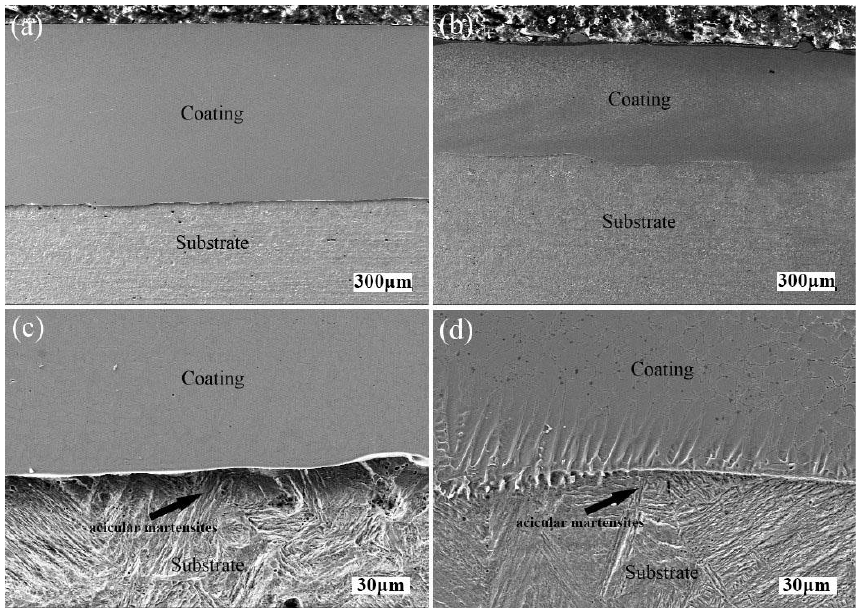
Figure 3. Macrograph of transverse cross-sections of Coating 1 and Coating 2: ( a ) overview of coating 1; ( b ) overview of coating 2; ( c ) bonding area of coating 1; ( d ) bonding area of Coating 2.